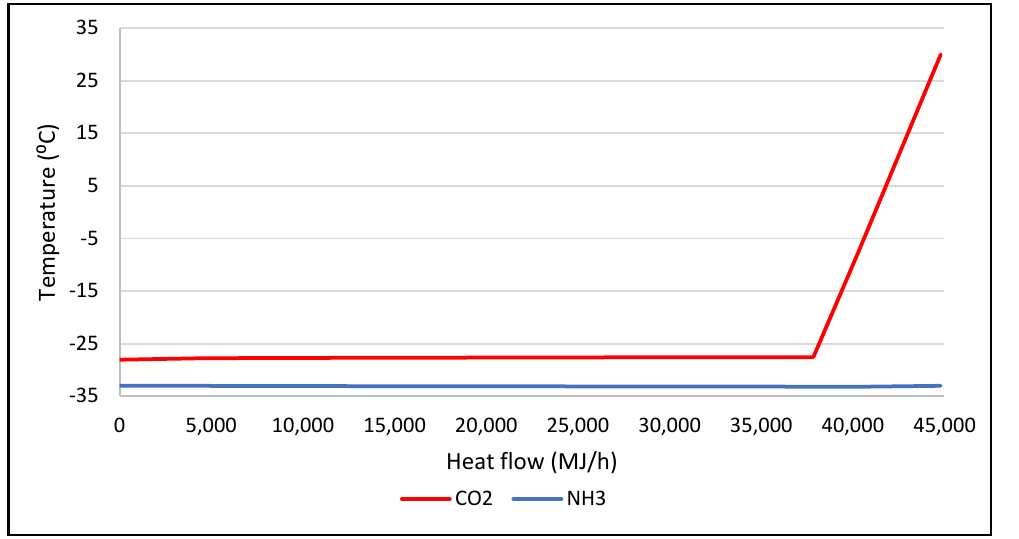
Figure 9. P – H diagrams of ammonia from 0.5 to 100 bar. The black lines illustrate the ammonia refrigeration cycle.